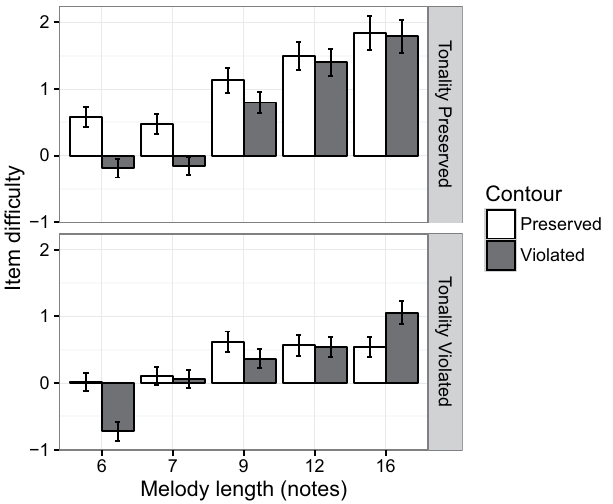
Figure 2. Item difficulty as a function of melody length, contour violation, and tonality violation (test Version 1). Error bars denote one standard error.